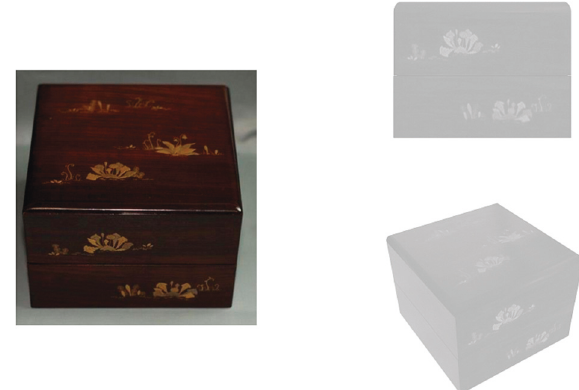
Figure 9: 3D reconstructed model of woodcut square box.